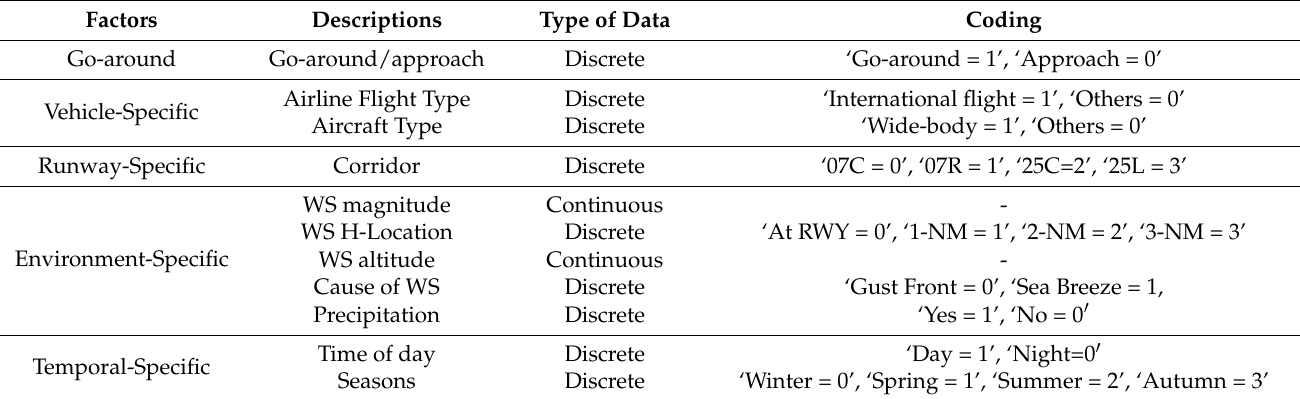
Table 4. Environmental and situational factors’ description and